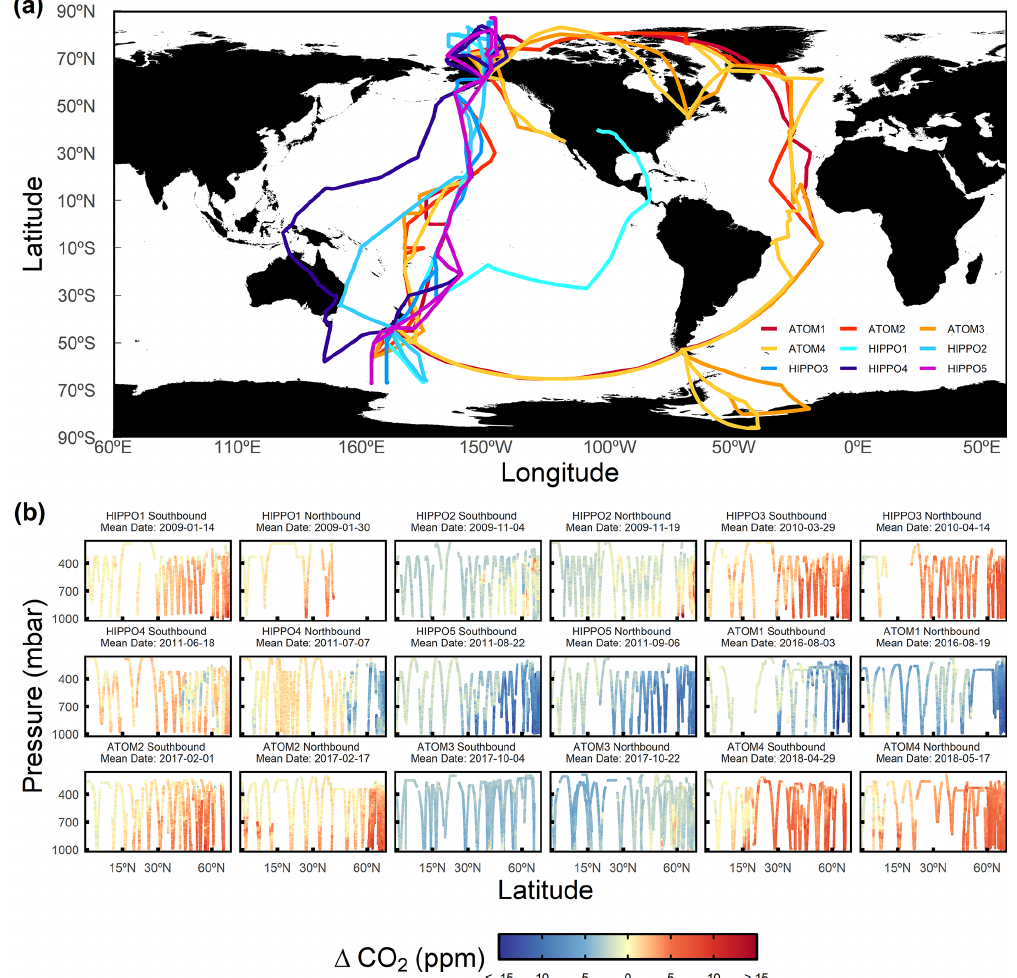
Figure 8. (a) HIPPO and ATom horizontal flight tracks colored by campaigns. (b) Latitude and pressure cross section of detrended CO 2 of each airborne campaign transect. CO 2 is detrended by subtracting the MLO stiff cubic spline trend, which is computed by a stiff cubic spline function plus four-harmonic functions with linear gain to the MLO